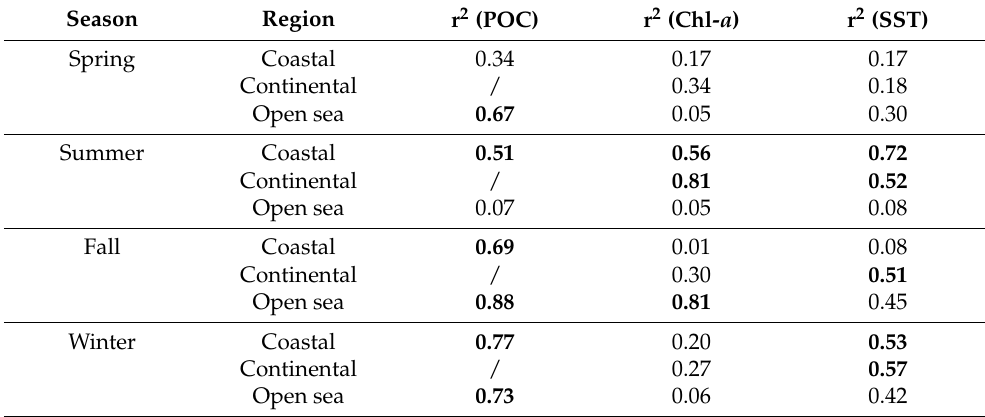
Table 1. Correlation between POC in continental shelf region with POC, Chl- a and SST in the studied regions ( p < 0.05). Bold numbers represent values with significant correlation. Season Region r 2 (POC) Spring